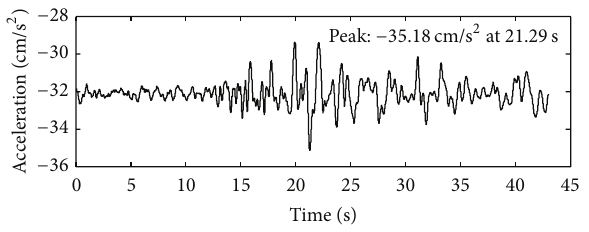
Figure 24: Acceleration time history (1).